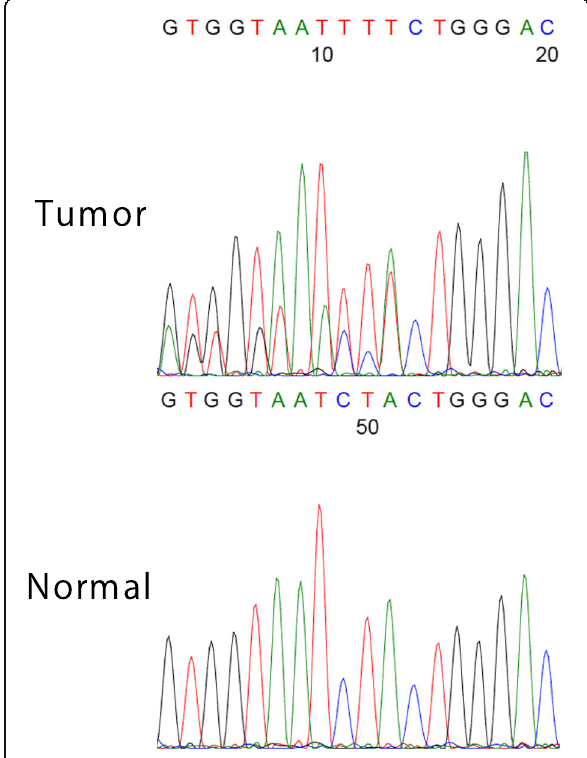
Fig. 3 TP53 mutation analysis of HGSC. A DNA sequence analysis of TP53 exon 8 from the ovarian and normal tissue with the reverse primer. The sequence of the ovarian tumor shows biallelic pattern